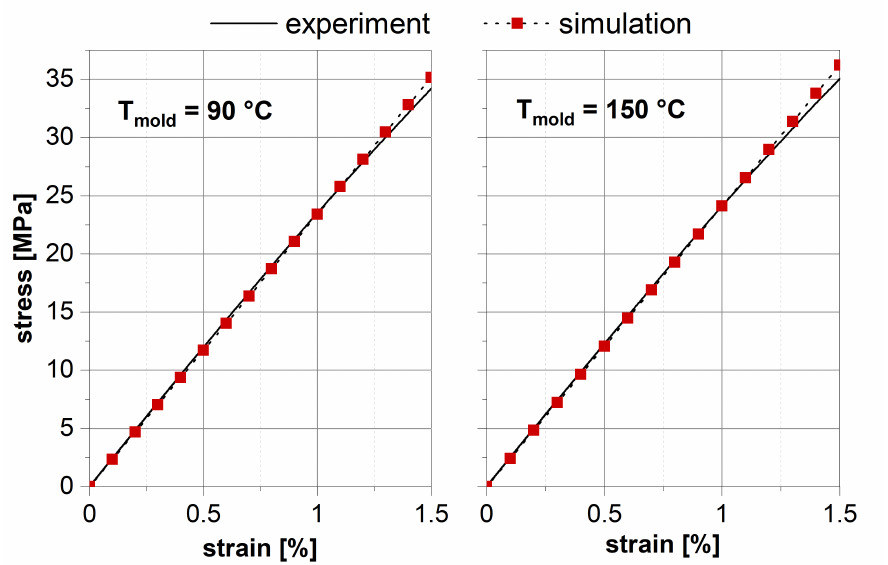
Figure 13. Comparison of experimentally determined and simulated stress responses to a given strain in an elastic tensile test for mold temperatures of 90 ◦ C and 150 ◦